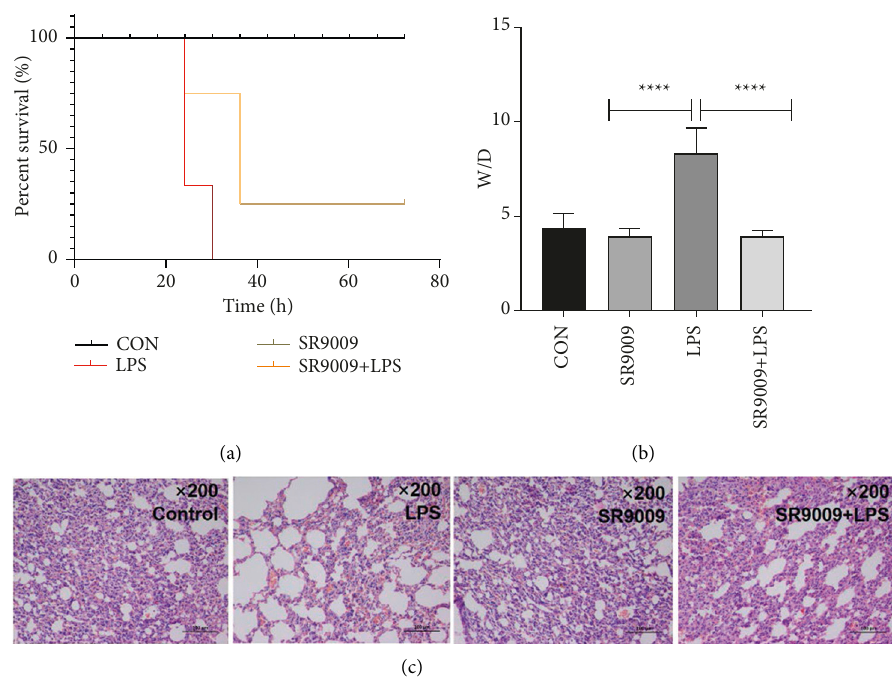
Figure 6: Effect of sepsis on lung tissue after SR9009 treatment: (a) the survival rate of rats after LPS, SR9009, SR9009+LPS, SR8278, and SR8278+LPS treatment; (b) the ratio of W/D was changed after LPS, SR9009, and SR9009+LPS treatment; and (c) the lung histopathology of mice after LPS, SR9009, and SR9009 +LPS treatment was observed by H&E staining. ∗∗∗∗ p < 0 .